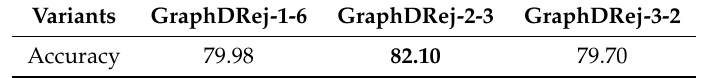
Table 7. The accuracy (%) for evaluation of GraphDRej with the same size of neighborhoods on